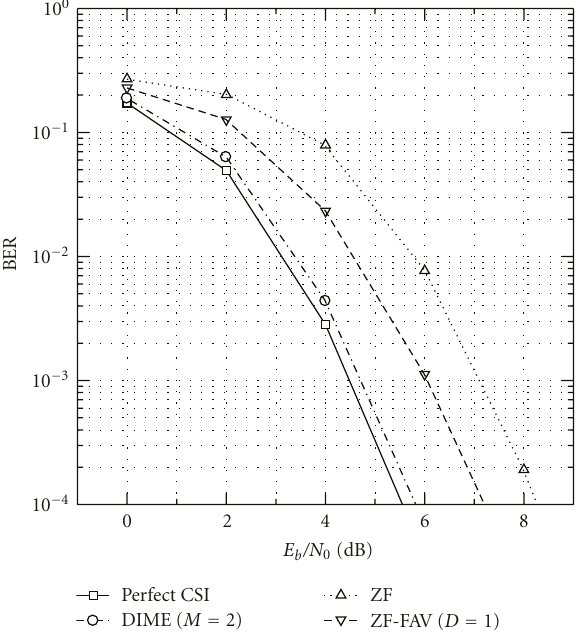
Figure 6: BER performance with 16-QAM-OFDM.